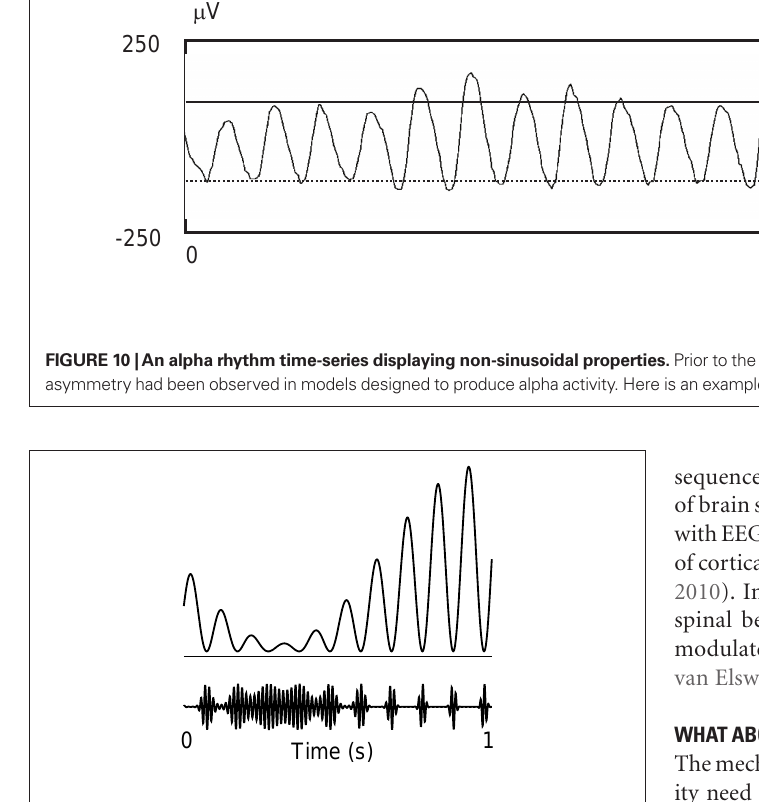
Figure 11 | rhythmic pulsing and it implications for processing – a hypothesis. The gamma burst (e.g., involved in visual processing) can only occur when the alpha signal is low enough, e.g., at the troughs. Thus, the periods of gamma activity become briefer with stronger alpha. When the alpha activity is sufficiently weak, gamma can occur during the whole cycle. This scheme is consistent with the notion of rhythmic pulsing. Adapted from Osipova et al.